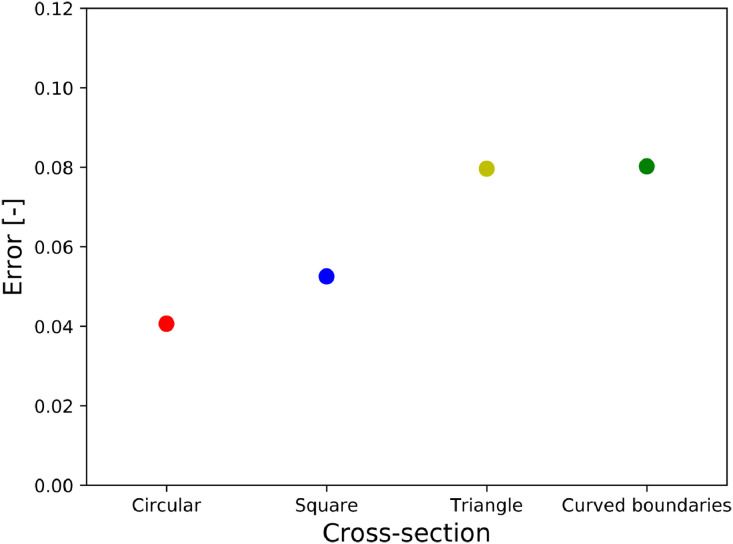
Deviation of LBM results from MS-P for the different cross-sectional shapes for Lc=80.